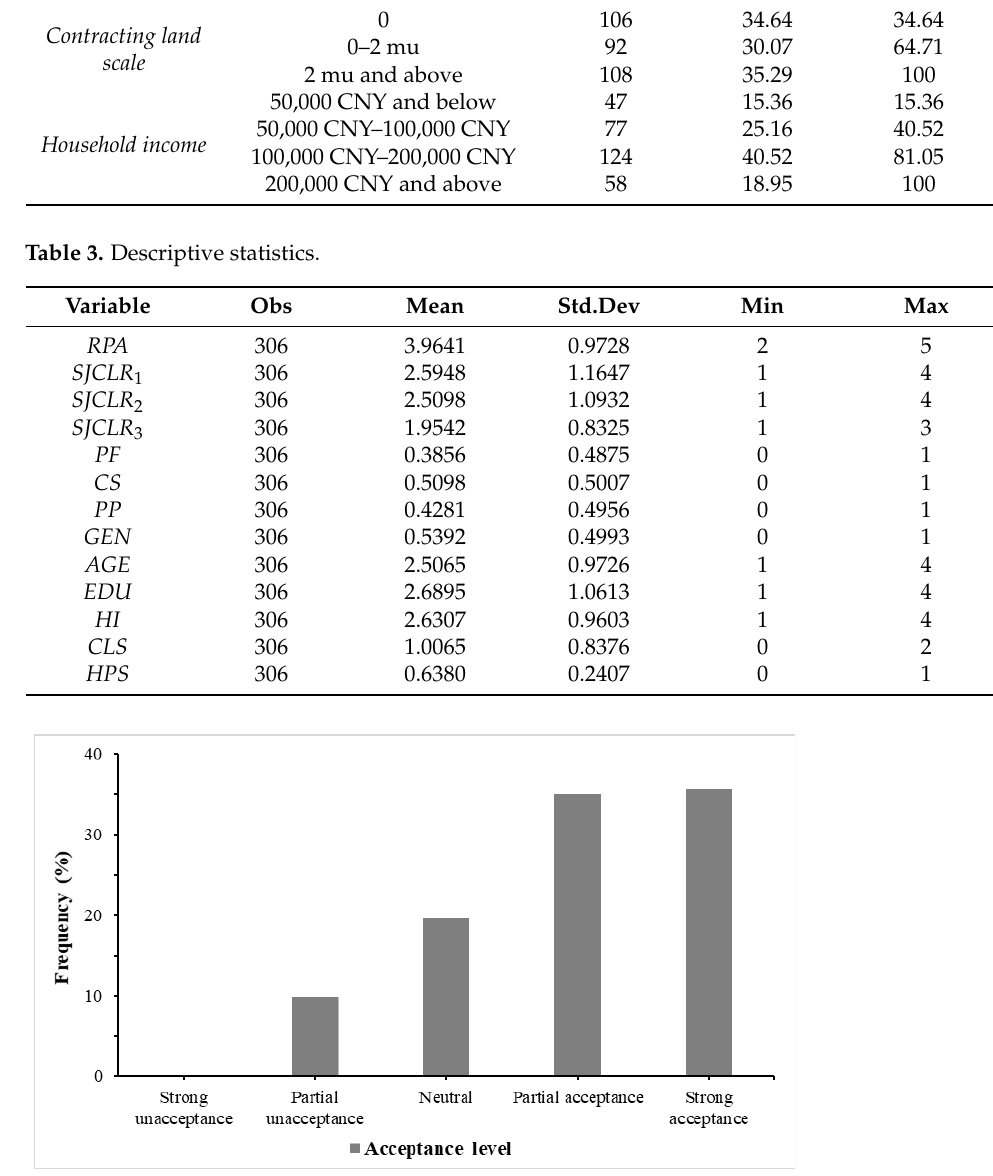
Figure 1. Distribution of the level of residents’ policy acceptance of CLR.